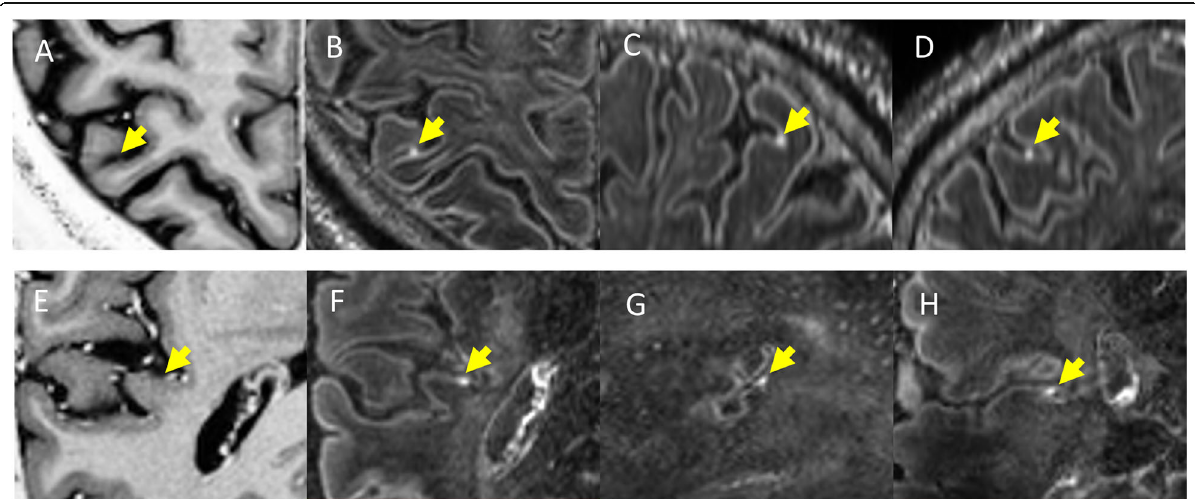
Fig. 2 Examples of “ nodular ” type enhancing foci in multiple sclerosis. In the horizontal rows are displayed two different patients with multiple sclerosis. T1-weighted magnetisation-prepared two rapid gradient echo images ( A , E ), along with axial ( D , H ), sagittal ( C , G ), and coronal ( B , F ) slices from contrast-enhanced magnetisation-prepared fluid-attenuated inversion recovery images. The yellow arrows indicate the location of a nodular focus of leptomeningeal contrast enhancement in all three planes and its expected location on magnetisation-prepared two rapid gradient echo images. Published with permission from J Neurol [53]